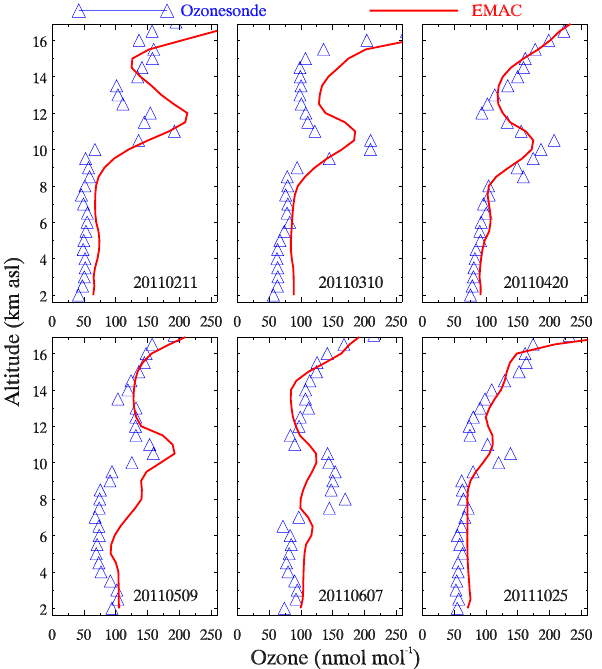
Figure 2. Comparison of EMAC-simulated ozone profiles during the days of SOP events with ozone-sonde observations over Naini-